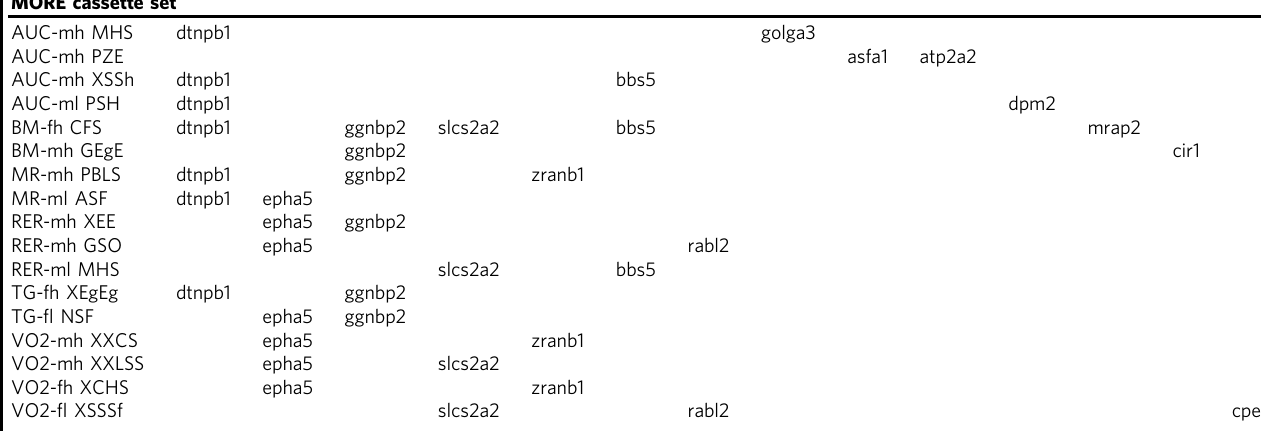
Table 3 Transcription factor-binding site alignment of MORE sets comprising a regulatory network of 14 genes MORE cassette